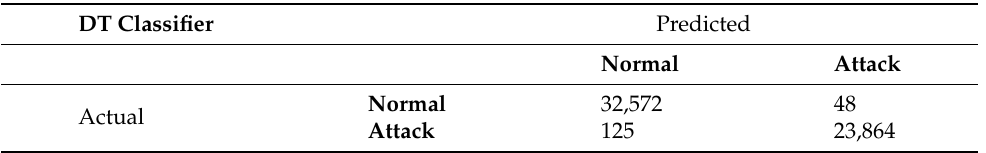
Table 8. Confusion matrix of Decision Tree (DT) classifier test for malicious and normal traffic detection over IoT healthcare dataset generated using IoT-Flock [16,24].